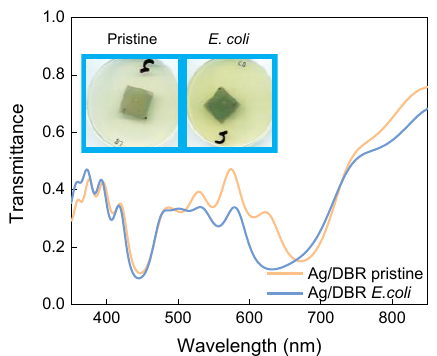
Fig. 1. Transmission spectrum of the pristine and E.coli- contaminated Ag/DBR. The inset shows the visual change in the reflection properties of the